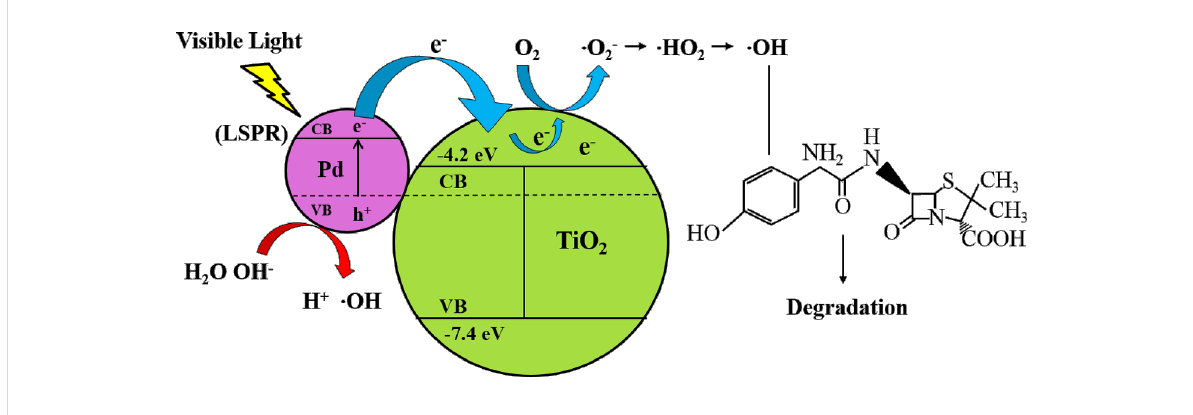
Figure 10: Schematic diagram of electron transfer and degradation mechanism of AMX.